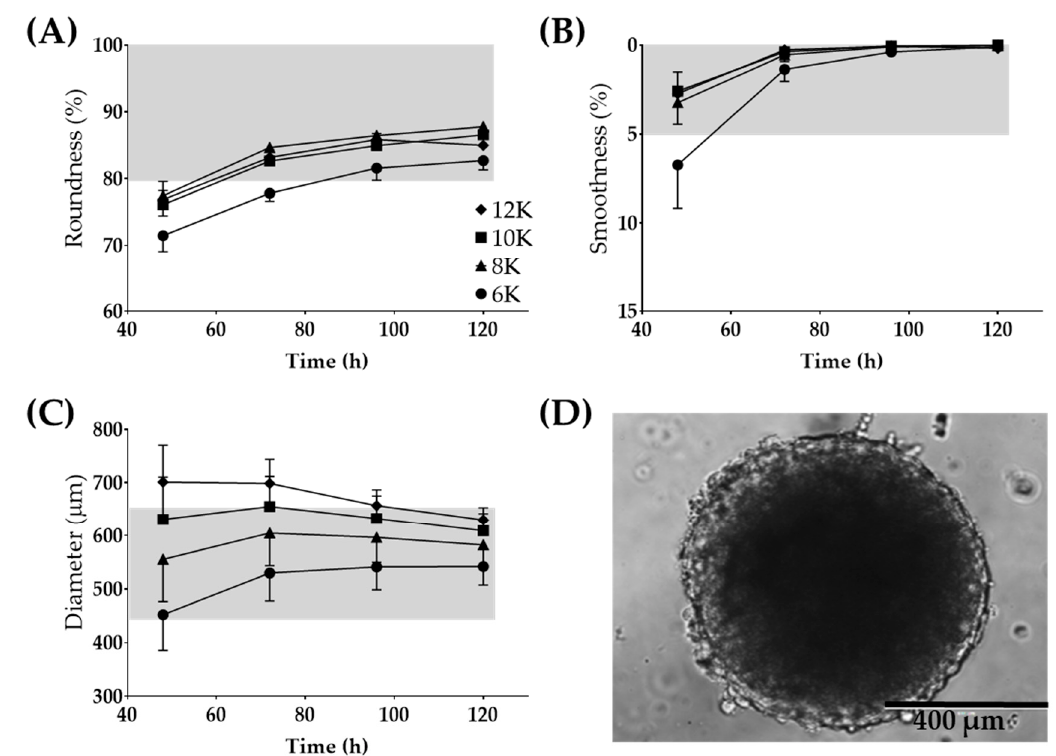
Figure 3. Large 12Z spheroids used for 3D biofabrication. Optimization for time post-seeding and the number of cells seeded for ( A ) roundness, ( B ) smoothness, and ( C ) diameter. ( D ) Representative image of a spheroid which fits all of the Regenova goal parameters. Scale = 400 µ m. Grey shading indicates the tolerability range. N = 3.